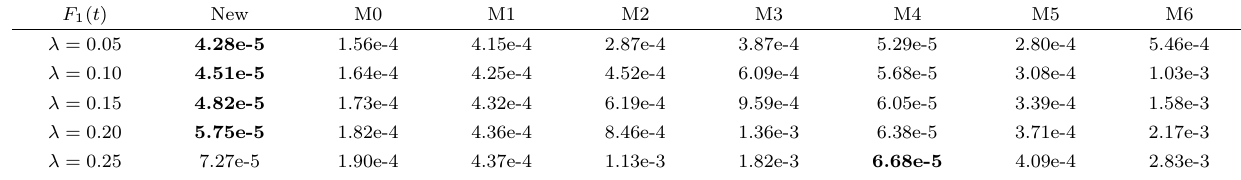
Table 3 Maximum errors of F 1 ( t